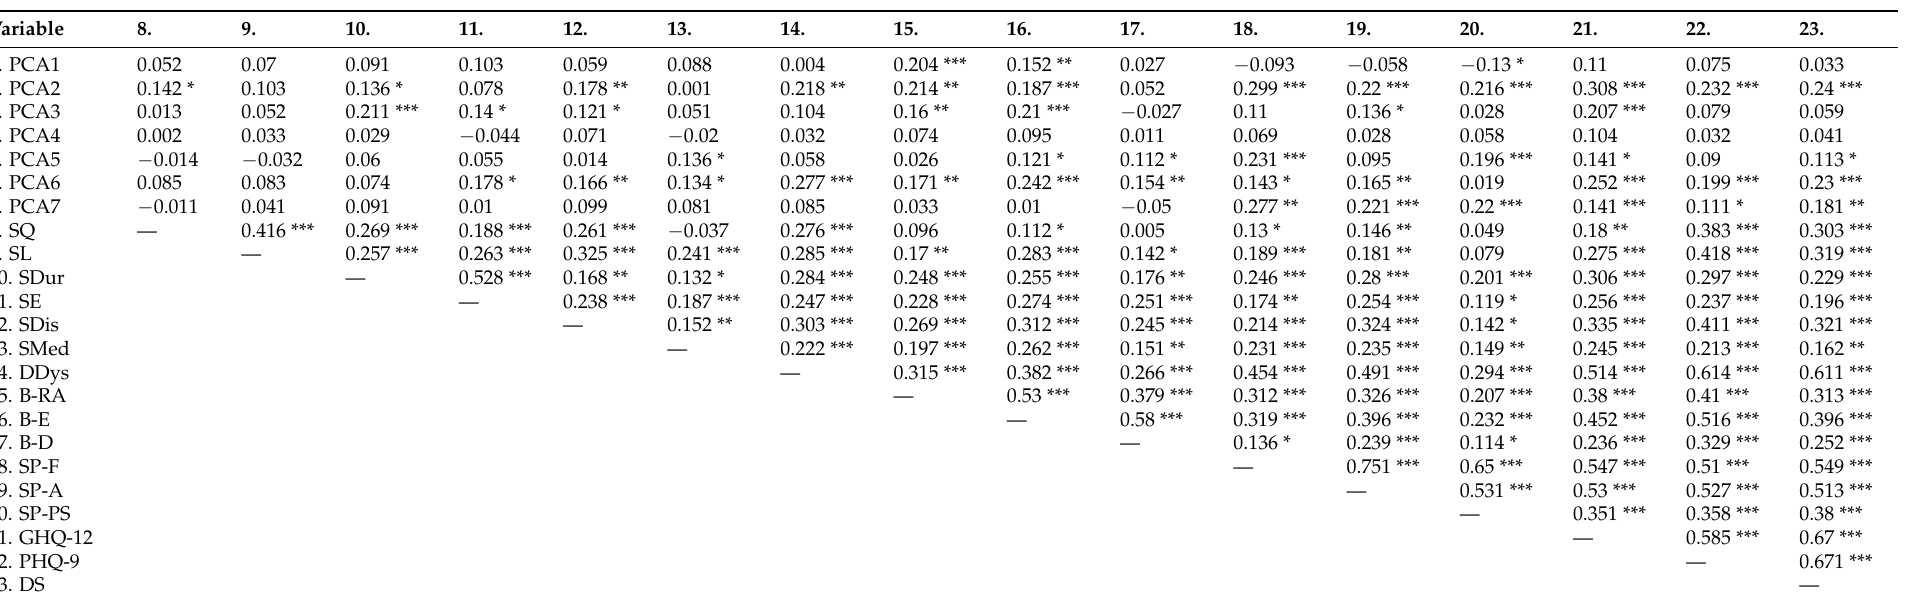
Table 1. Correlation coefficients of analysed